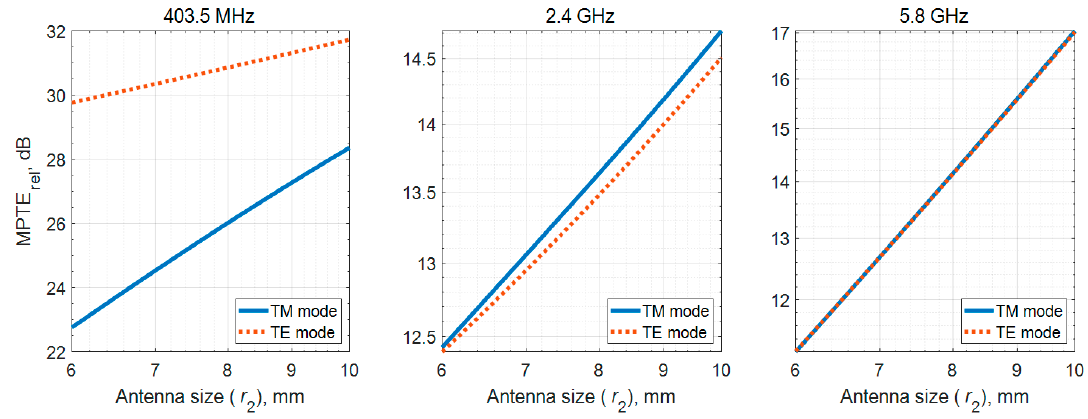
Figure 8. MPTE rel results when the insulator layer is composed of zirconia, which is the optimal material based on previous results.